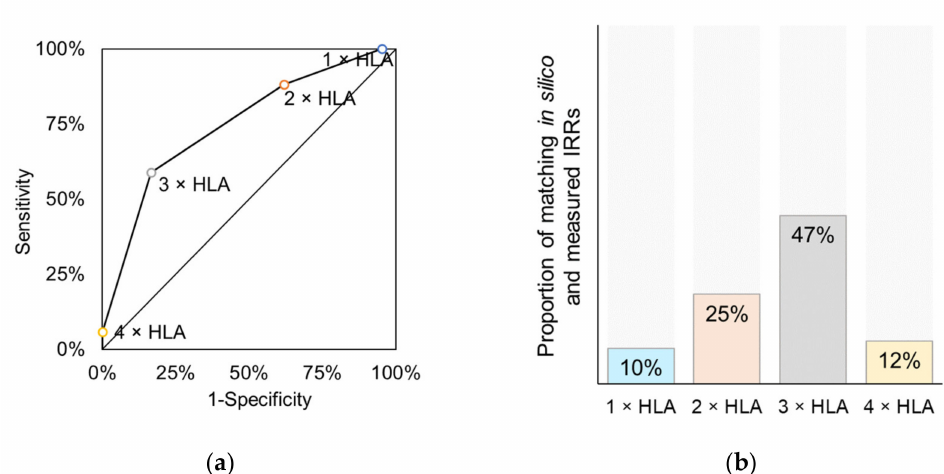
Figure 4. Performance evaluation of the in silico trials. ( a ) Example of a Receiver Operating Characteristic (ROC) curve of the in silico IRR predictions when the success threshold is considered as ≥ 70% IRR (AUC = 0.75) (related to Table S2). ( b ) Pairwise Chi square analysis of measured and predicted IRRs; bars represent the proportion of the analyzed data pairs where difference was not significant ( p > 0.05). Analyzed dataset was the same as used for Figure 3 (59 data pairs covering 79 CTs with 55